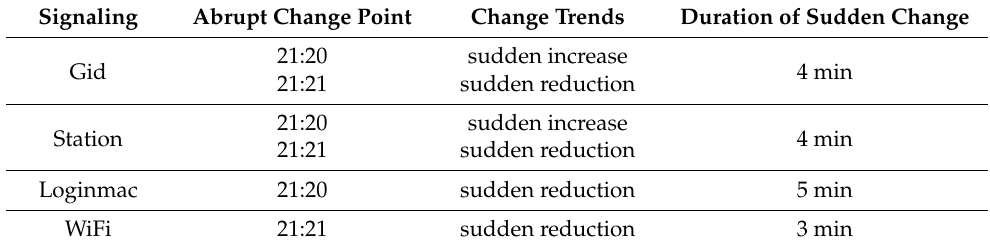
Table 3. Four types of signaling sudden